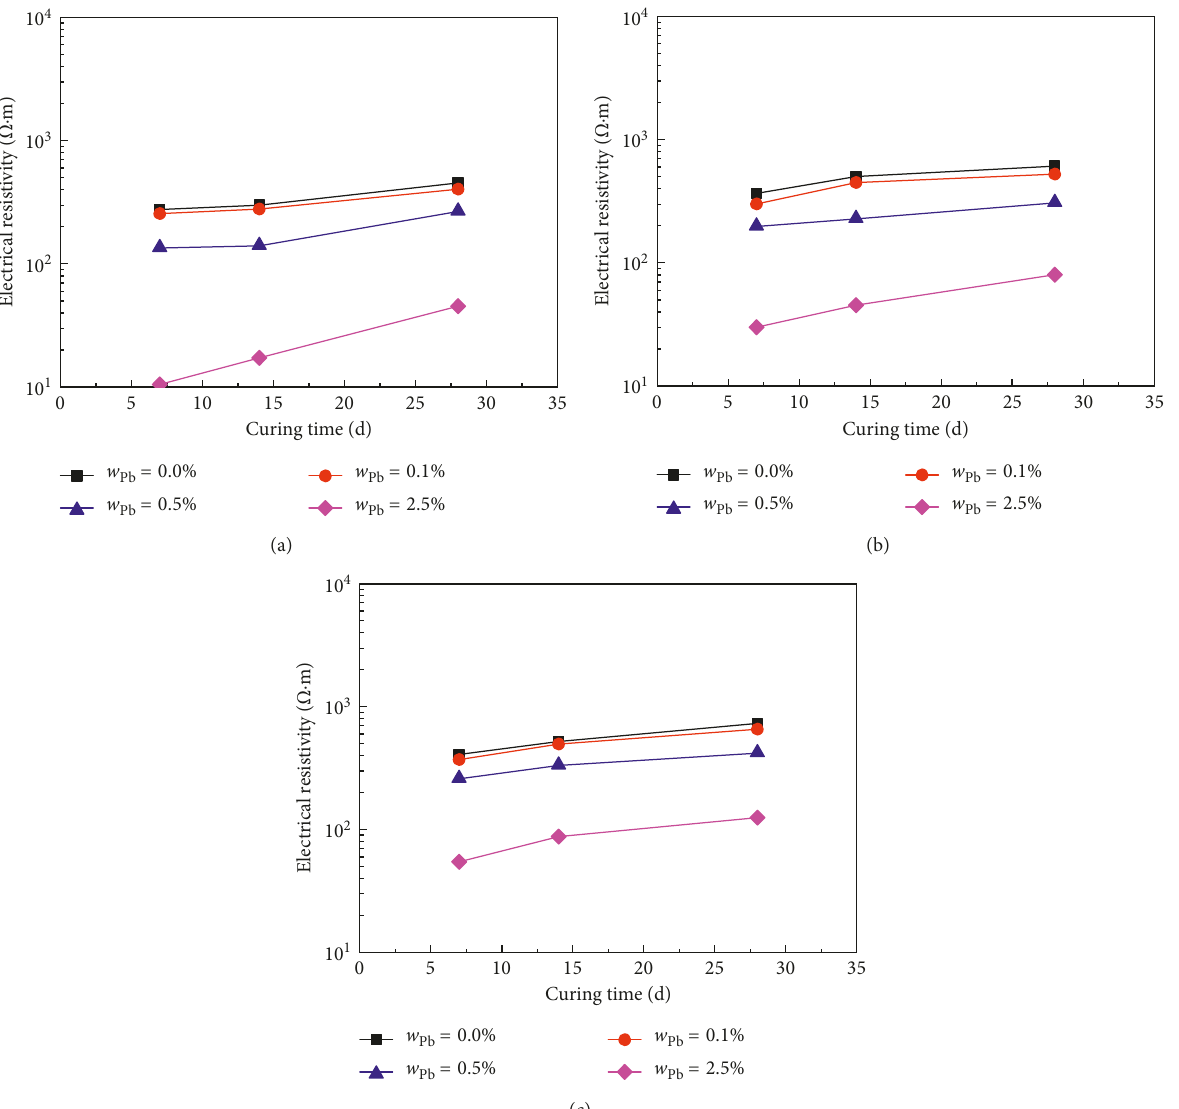
Figure 4: Variation of electrical resistivity with curing time of specimens of soil S2: (a) a